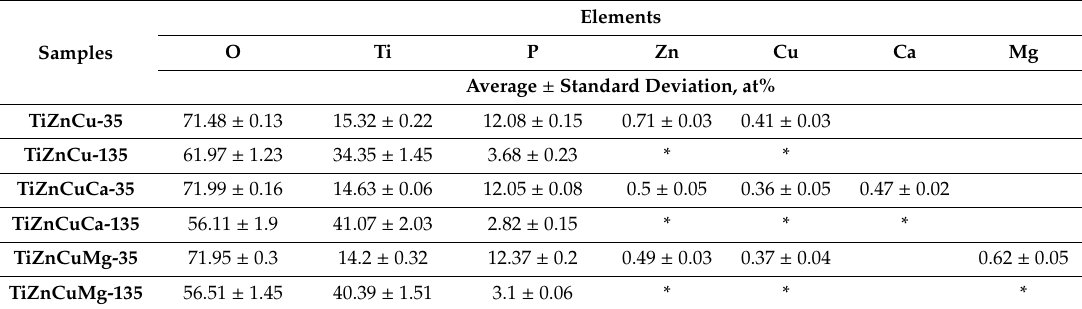
Table 4. Results of EDS analysis of PEO coatings, at%.